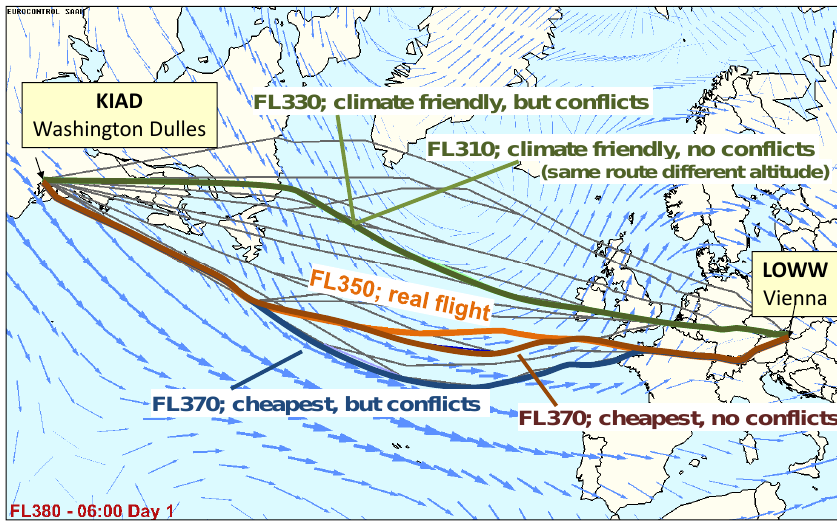
Fig. 14. Examples of climate-optimised flights. The optimisation was performed with respect to question Q1 (short-term climate impacts, AGWP20, see Table 7) for one particular winter weather pattern (zonally strong jet). The selected city pair connection is Washington to Vienna. The real flight at that day is shown in light brown. The economic optimal flights without conflict avoidance is given in blue and the conflict avoidance is given in dark brown. The climate optimal flights are shown in green. In this case the aircraft trajectories with and without conflict avoidance differ only in cruise altitude. Arrows indicate the wind field at flight level 380, i.e.